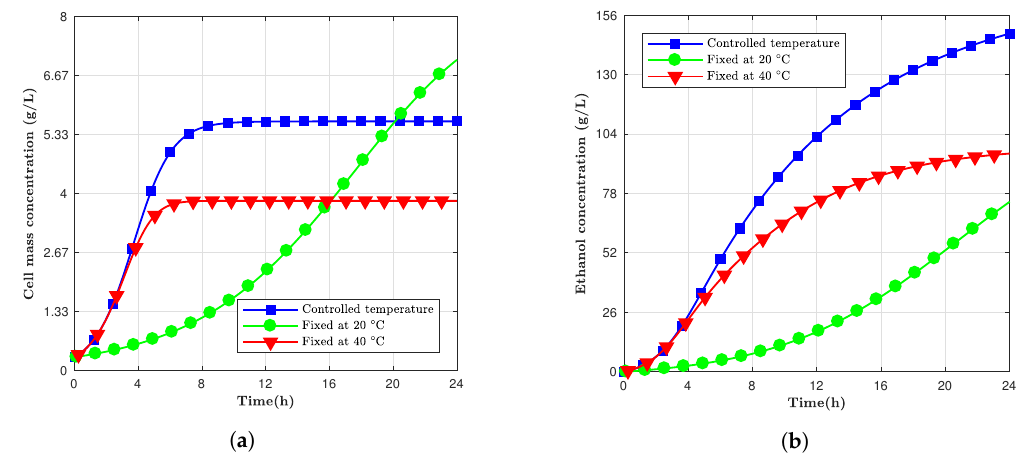
Figure 4. The concentration of ( a ) cell mass and ( b ) ethanol for simulations at fixed and controlled temperatures in a 24 h window. Table 7. Final cell mass and ethanol concentration after 24 and 60 h simulations for fixed and controlled